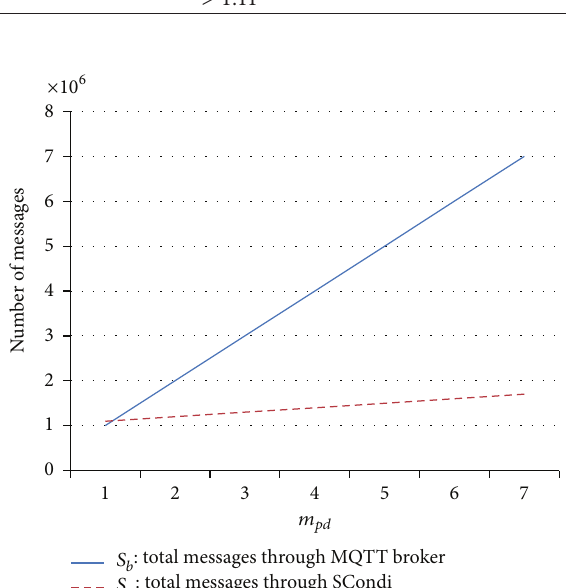
Figure 5: 𝑚 𝑝𝑑 effect on total amount of